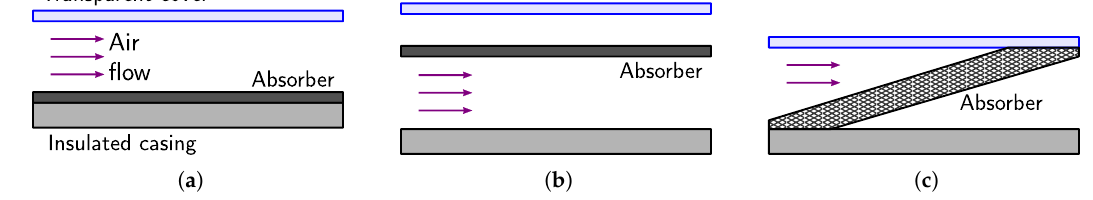
Figure 2. Solar air collector. ( a ) Air flow above the absorber. ( b ) Air flow below the absorber. ( c ) Air flow through the absorber (porous